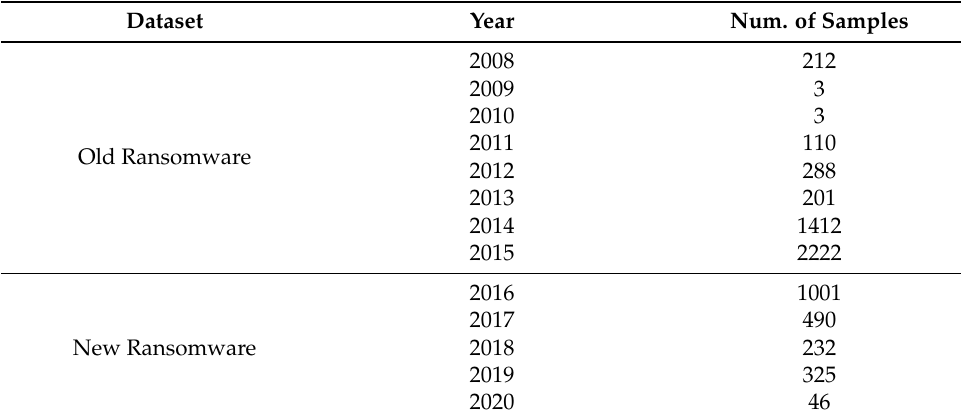
Table 4. The distribution of ransomware APKs based on dex date. Dataset Year Num. of Samples